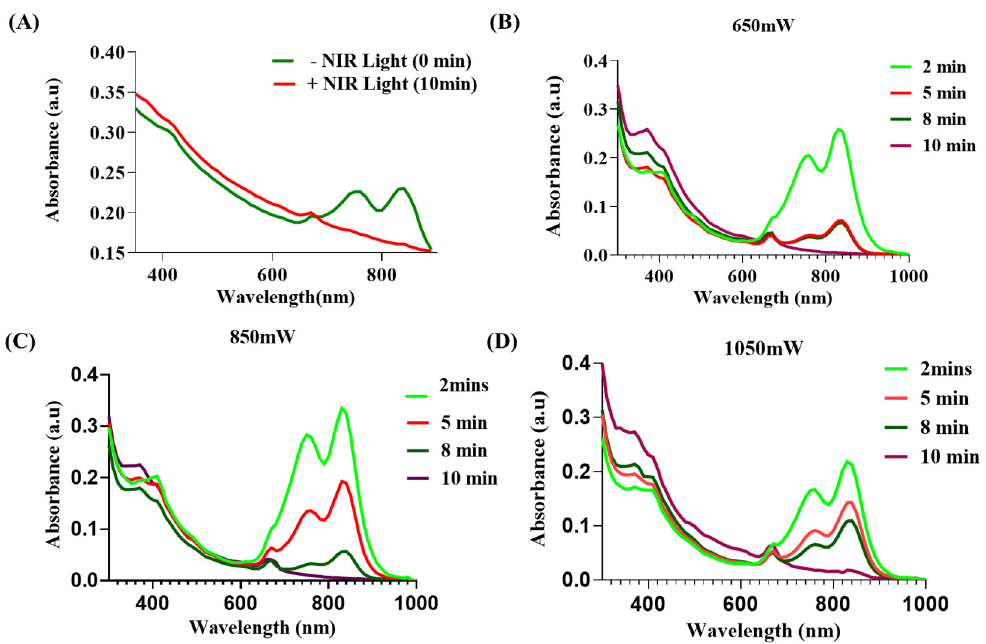
Figure 3. PTT-mediated release/degradation studies of the MI PNPs during exposure to NIR 808 nm light. ( A ) Line graph indicating the UV-vis spectra before and post-NIR light irradiation. ( B – D ) UV-vis spectra of MI PNPs indicating the release/degradation using various power intensities of NIR light.